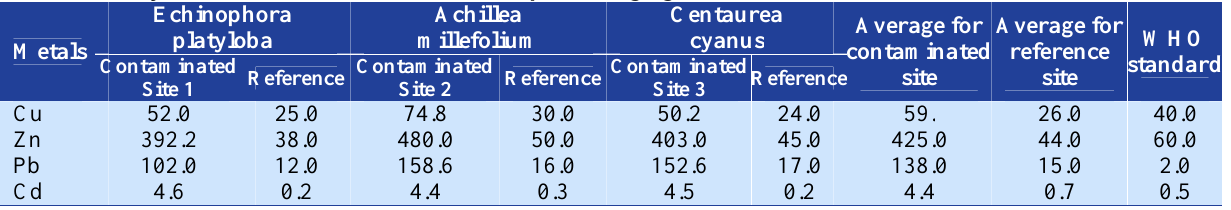
Table 5. Heavy metals concentrations in medical plants